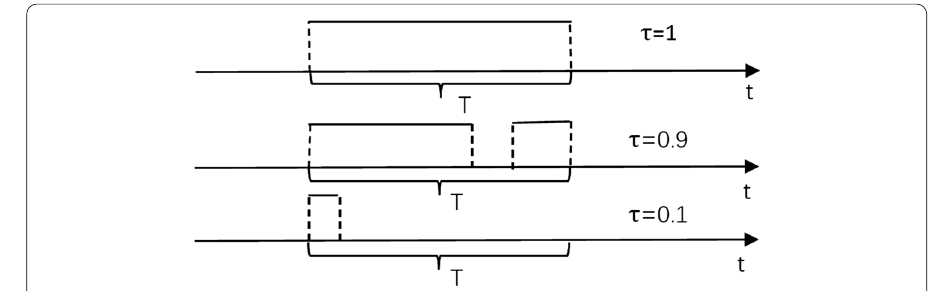
The existing method The proposed